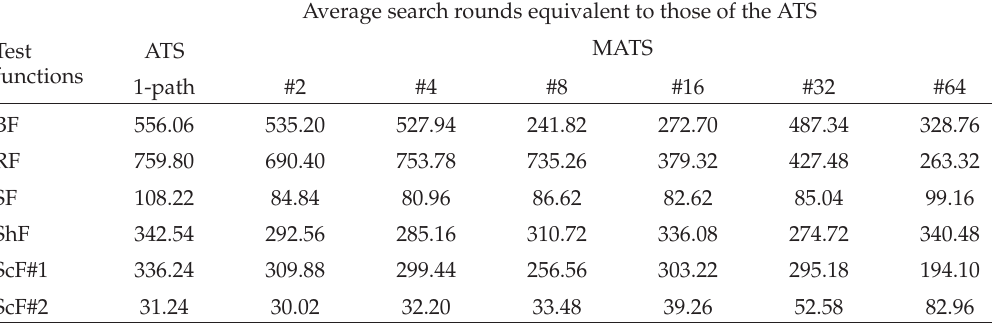
Table 7: Equivalent average search rounds with respect to the